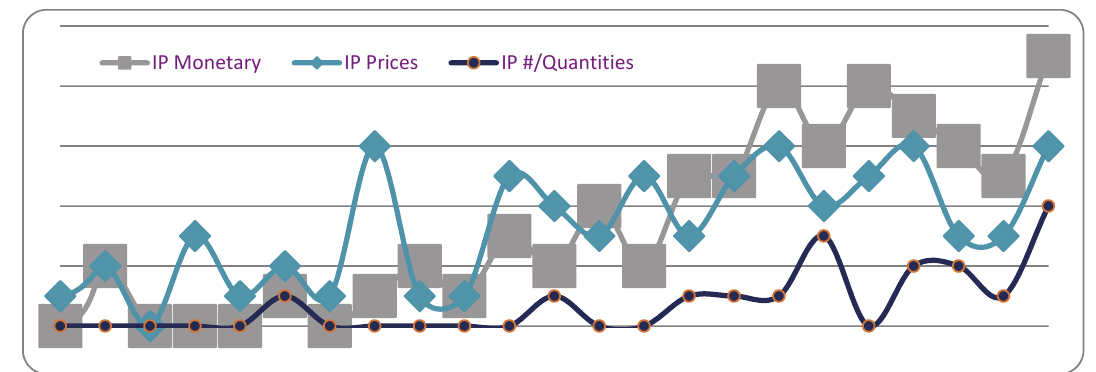
Fig. 10. Number of Life Insurance Efficiency Studies Using Different Input Proxy Forms With no Author Duplication (Year-by-Year)